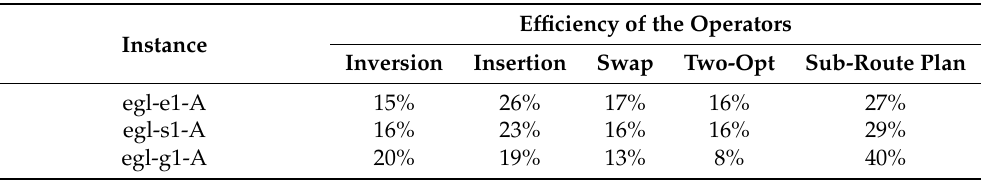
Table 7. The efficiency of the move operators compared with each other within the CARP-ABC algorithm, measured on instances of different